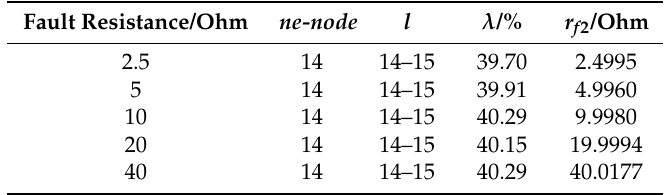
Table 9. Locating results of Strategy 1 with different fault resistances.